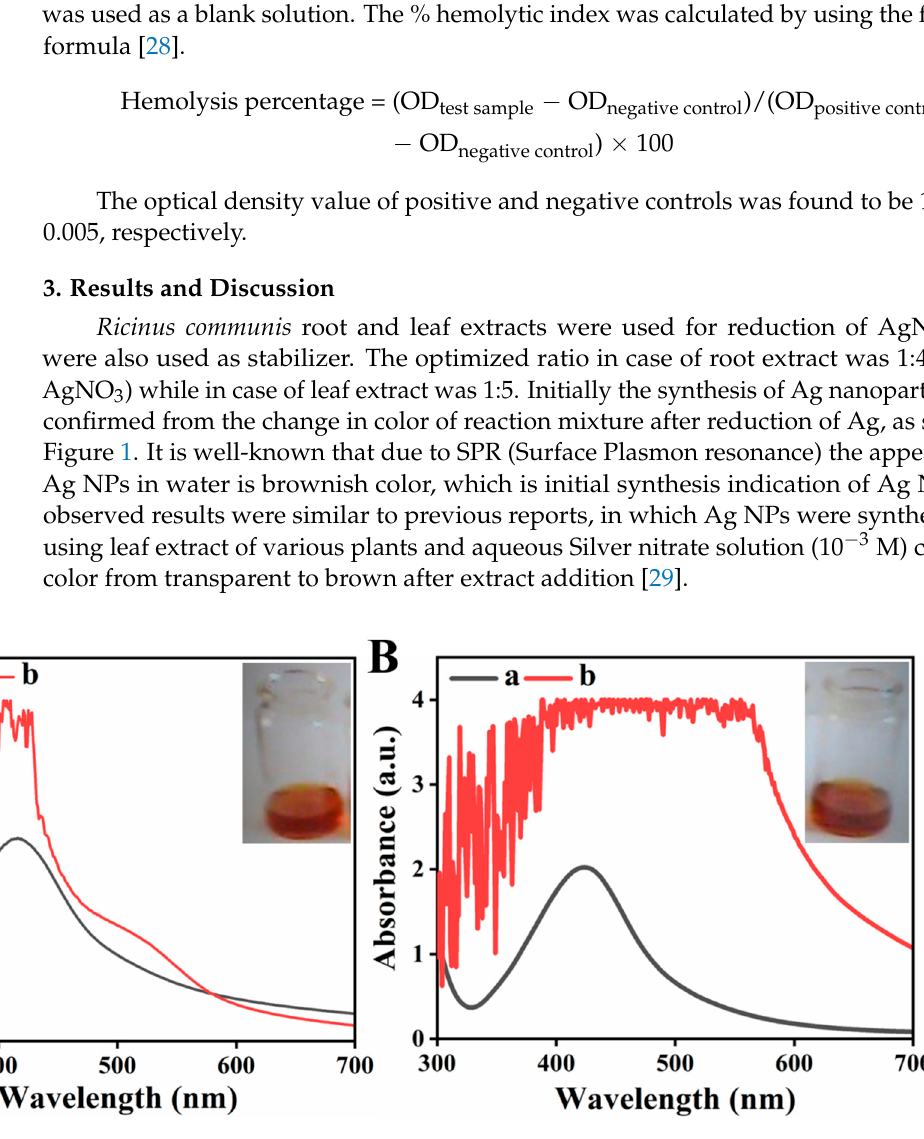
Figure 1. UV-Vis spectra of ( A ) Root ( B ) Leaf where (a) plant extract and (b) Corresponding Silver nanoparticles.